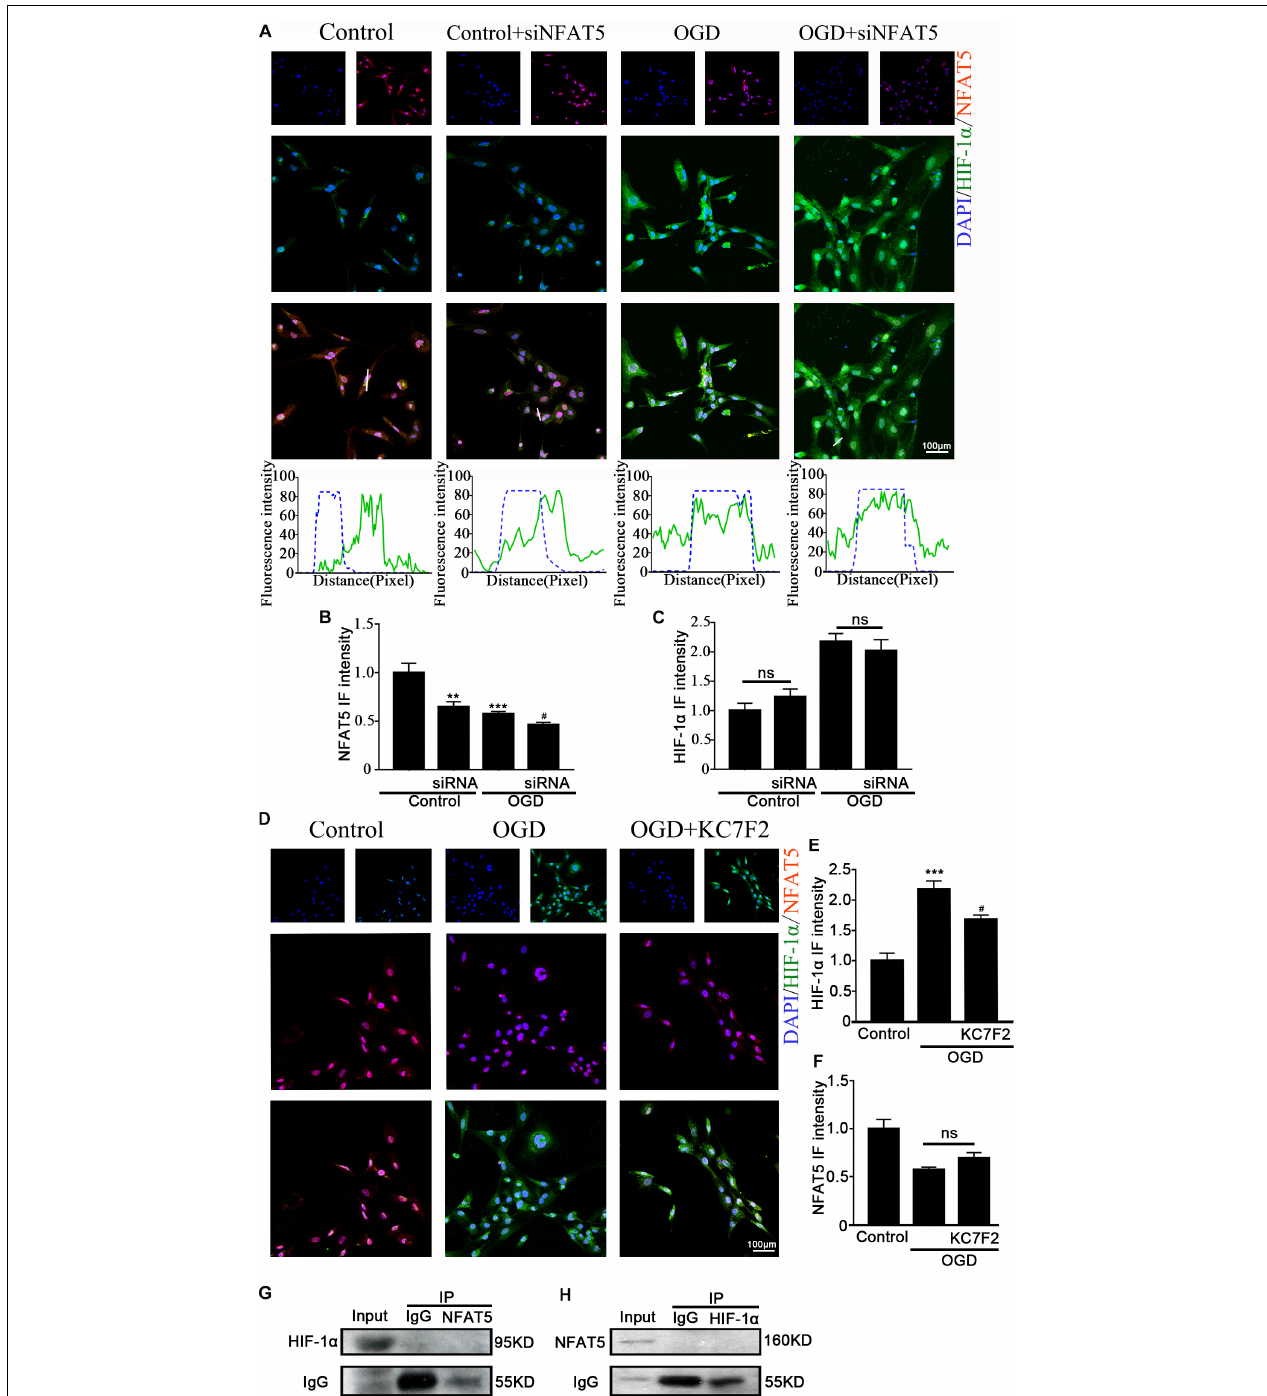
FIGURE 6 | Interaction between NFAT5 and HIF-1 α after OGD. ( A , top) Confocal image demonstrating NKCC1 expression in neurons after transfection with NFAT5-specific siRNA. ( A , bottom) Side overlap of two peaks indicated as a partial co-localization (highlighted by the white line). (B,C) The intensity of NFAT5 and HIF-1 α fluorescence was determined in 10 fields/well and divided by the number of cells counterstained with DAPI. (D) Confocal image demonstrating NFAT5 expression in neurons after treatment with KC7F2. (E,F) The intensity of NFAT5 and HIF-1 α fluorescence was determined in 10 fields/well and divided by the number of cells counterstained with DAPI. (G) Co-IP of endogenous NFAT5 and HIF-1 α in primary cultured hippocampal neurons assessed in neurons at 6hr after OGD. After immunoprecipitation with NFAT5 beads, the purified proteins, along with input samples, were detected by western blotting with anti-HIF-1 α and anti-IgG antibodies. (H) After immunoprecipitation with HIF-1 α beads, the purified proteins, along with input samples, were detected by western blotting with anti-NFAT5 and anti-IgG antibodies. The values represent the mean ± SEM. ∗∗ p < 0.01, ∗∗∗ p < 0.001 versus control (Tukey’s test after one-way ANOVA). # p < 0.05 versus OGD (Tukey’s test after one-way